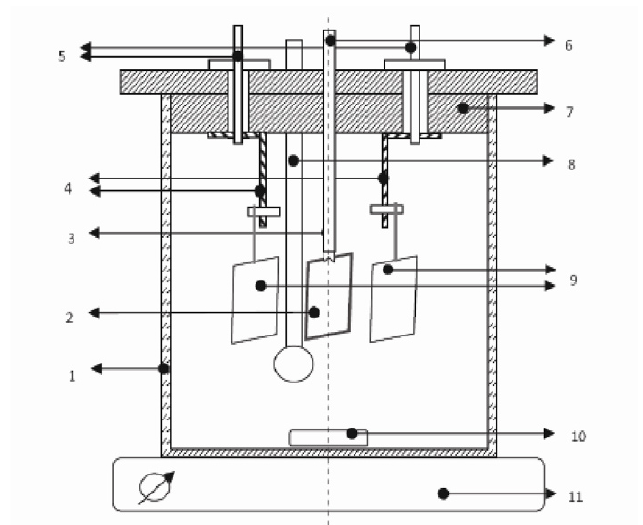
Figure 1. Thin films electrodeposition laboratory device: 1.electrolysis vessel (capacity 600 cm 3 ); 2.Cathode (steel sample); 3.bracket of steel sample; 4.brackets of cell anodes; 5.electrical contacts for anodes; 6.electrical contact for cathode; 7.cell cover; 8.reference electrode (ESC); 9.anodes; 10.magnetic stirrer; 11.magnetic heater